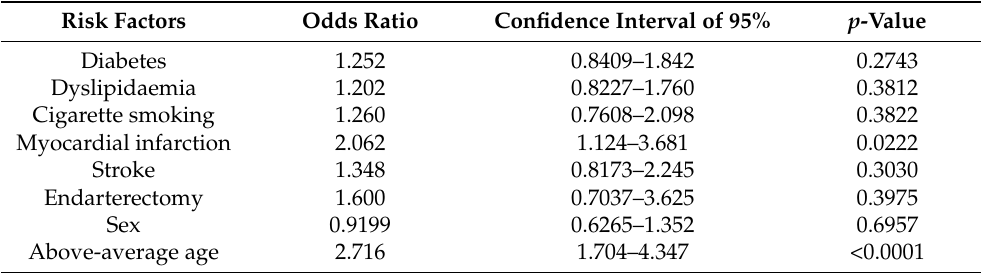
Table 7. Analysis of the correlations between the risk factors and worsening of stenosis in hyperten- sive patients (worsened patients: 241; stable patients: 188; and total patients: 429).